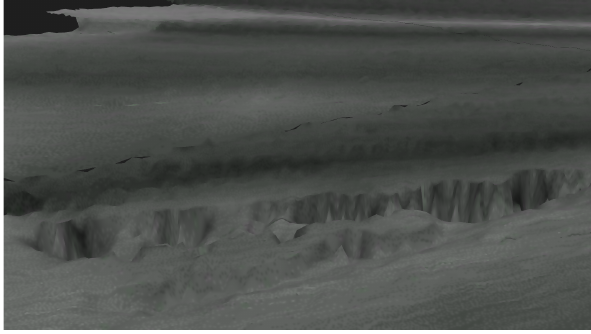
Figure 12. Example of real-time visualisation of reconstructed Martian terrain from MER